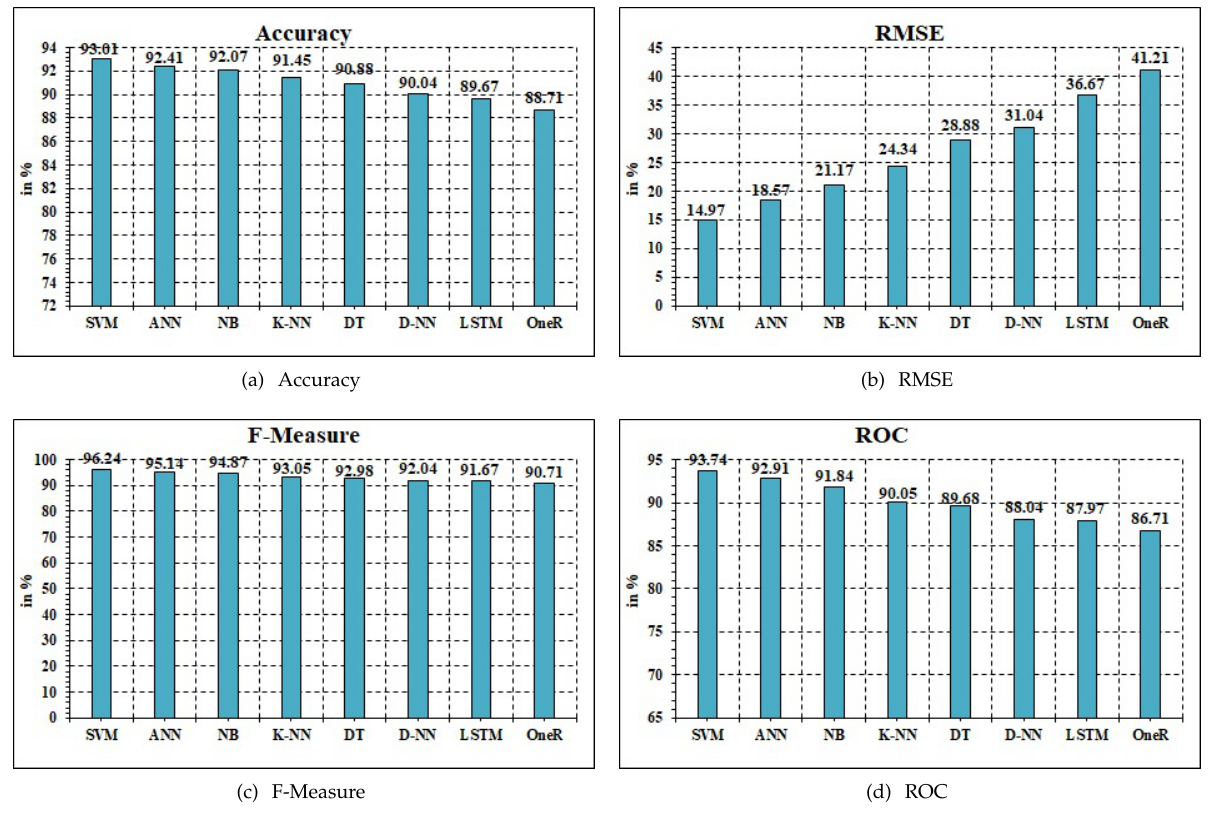
Figure 8. Performance measures. Table 3. Performance